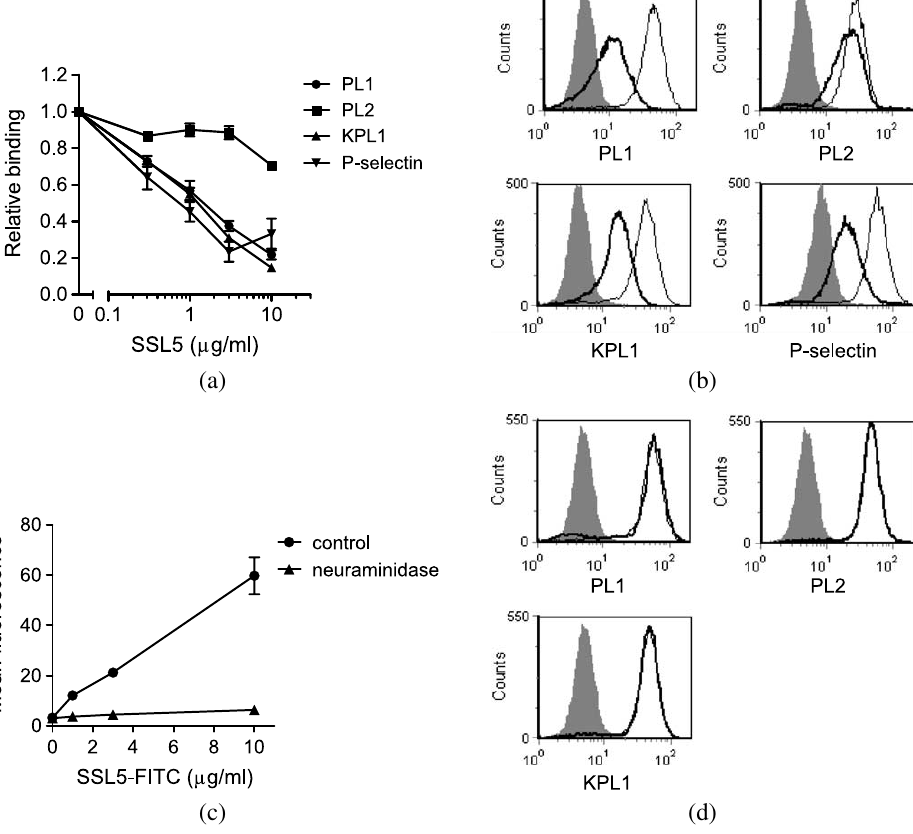
Fig. 2. SSL5 binds PSGL-1 on HL-60 cells in a glycan-dependent manner. (a) HL-60 cells were treated with 0–10 µg/ml SSL5 for 30 min at 4 ◦ C. Subsequently, binding of 1 µg/ml P-selectin or anti-PSGL-1 mAbs PL1, PL2, or KPL1 was examined. Data represent relative ligand binding to cells treated with SSL5 compared to control-treated cells and are mean values ± SEM of four independent experiments. (b) Histograms depict binding of PL1, PL2, KPL1, or P-selectin to HL-60 cells with (thick line) or without (thin line) pretreatment with 10 µg/ml SSL5. Grey histograms represent cells only stained with the secondary antibody. Results are representative of three independent experiments. (c) HL-60 cells were treated with 0.2 U/ml neuraminidase for 45 min at 37 ◦ C and examined for binding of 0–10 µg/ml SSL5-FITC. Data are mean values ± SEM of three independent experiments. (d) Binding of 1 µg/ml anti-PSGL-1 mAbs to neuraminidase-treated HL-60 cells preincubated with (thick line) or without (thin line) 10 µg/ml SSL5. Grey histograms represent cells only stained with the secondary antibody. Representative of three experiments. video S5: http://www.qub.ac.uk/isco/JCO/),